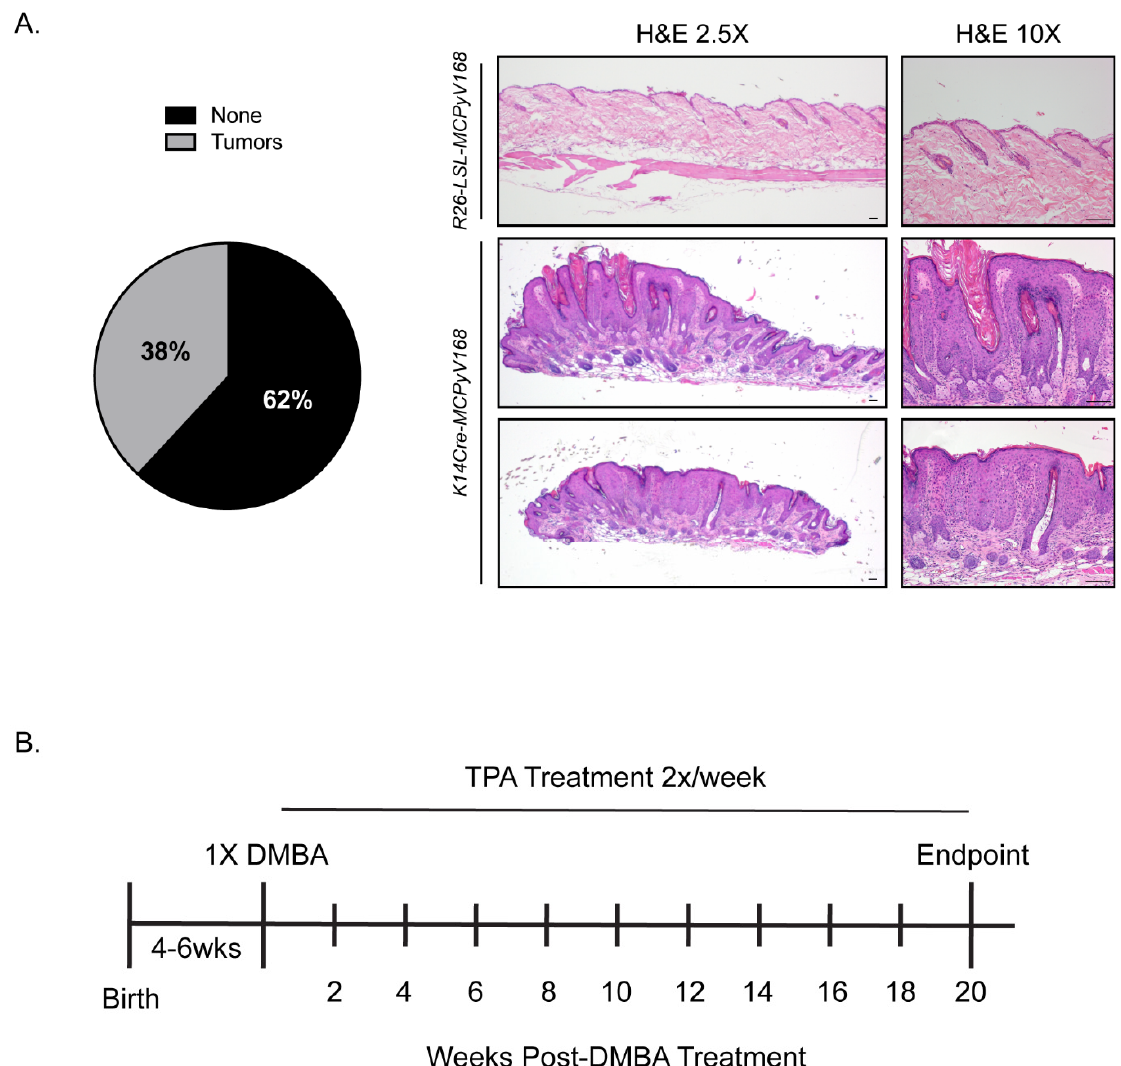
Figure 1. Model validation and experimental overview to determine the role of the MCPyV T antigens in skin carcinogenesis. (A) Spontaneous tumor development in untreated K14Cre-MCPyV168 transgenic mice. The pie chart on the left reflects the percentage of K14Cre-MCPyV168 mice that did (gray) or did not (black) develop spontaneous tumors. Representative H&E-stained images are shown on the right. Normal skin from Rosa26-LSL-MCPyV168 mice is shown on top, and sections from two representative spontaneous squamous papillomas that developed on K14Cre-MCPyV168 mice are shown in the middle and bottom panels. All scale bars = 100 µ M. (B) Experimental overview of DMBA and TPA treatment regimens in skin carcinogenesis studies. At 4–6 weeks of age, areas of dorsal skin were shaved and prepared in three groups of mice: Rosa26-LSL-MCPyV168 , K14E6/E7 , and K14Cre-MCPyV168 . For mice treated with DMBA only, a one-time topical treatment was applied to the shaved dorsal skin. For mice treated with TPA only, topical treatment was performed twice a week for 20 weeks. For DMBA+TPA treatment, these topical treatments were combined. Mice were monitored for tumor development every 2 weeks during the 20 week treatment period. The average number of tumors per mouse per group was quantified at each time point.